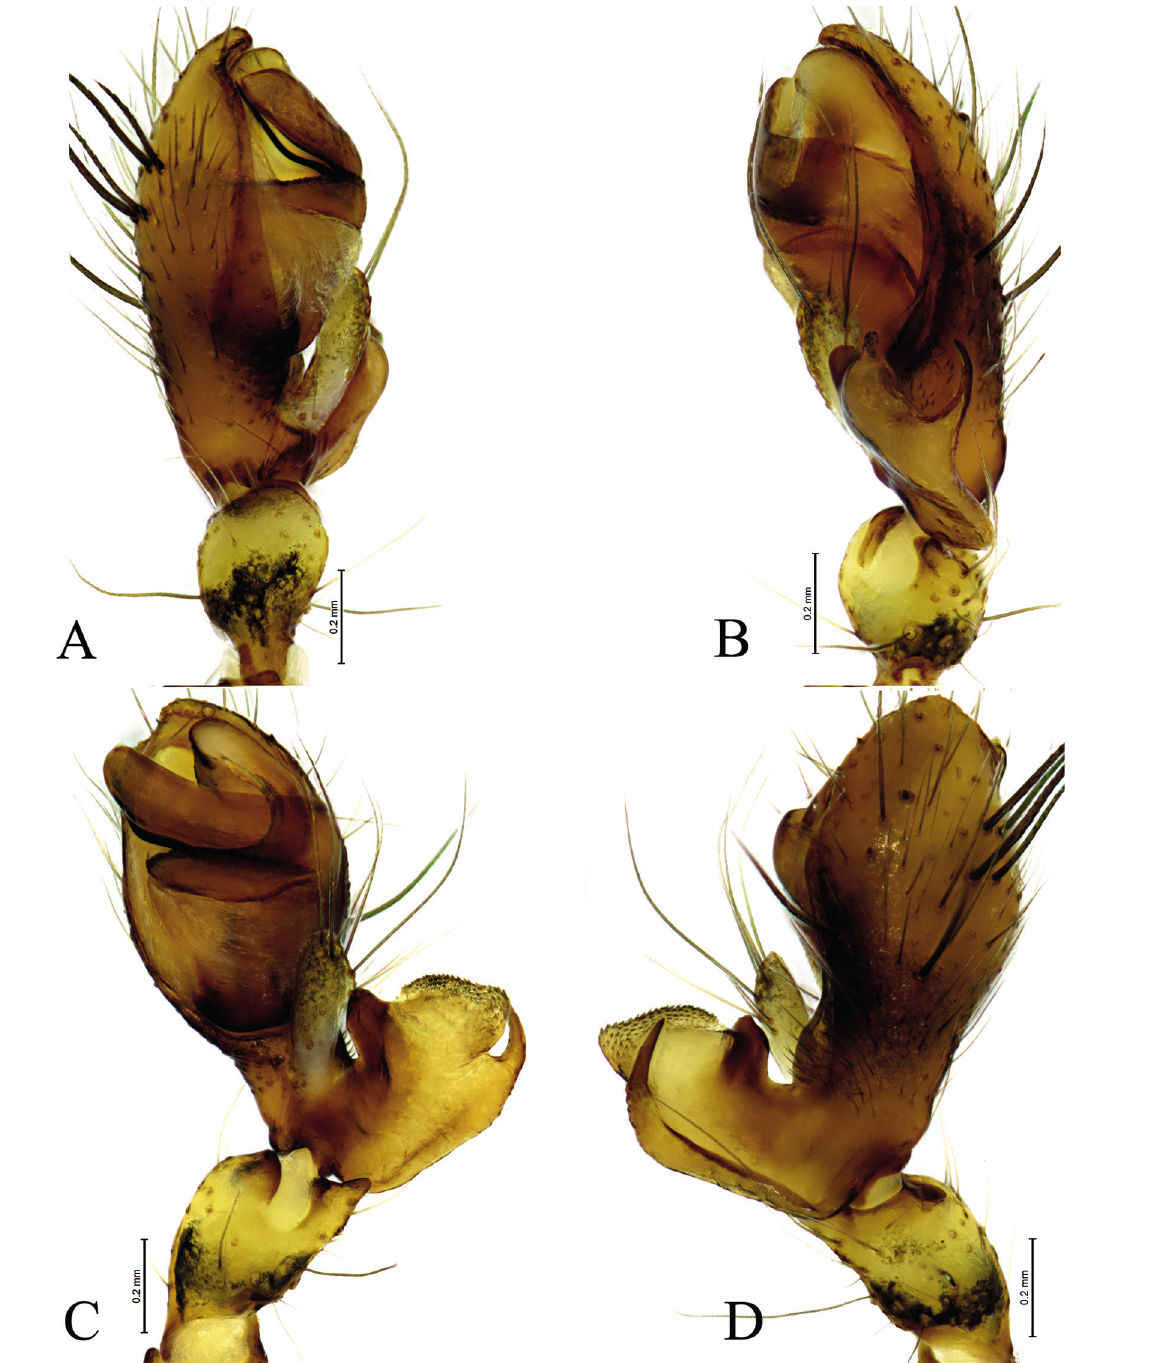
Fig. 17. Meta wanglang sp. nov., ♂, holotype (SWUC-T-TEg-07-01). A . Left palp, prolateral view. B . Same, ventral view. C . Same, retrolateral view. D . Same, dorsal